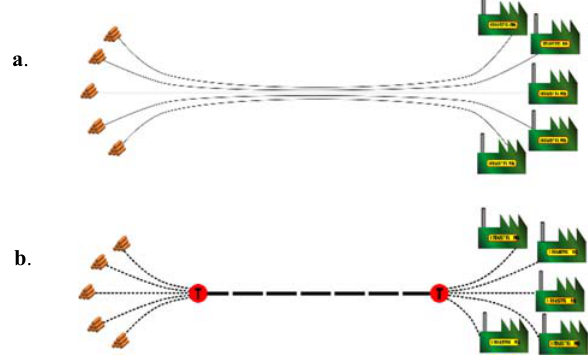
Figure 2. ( a ) Parallel conventional transport flows; ( b ) multiplex corridor transport flow with joint high ‐ capacity transport (HCT) between terminals.